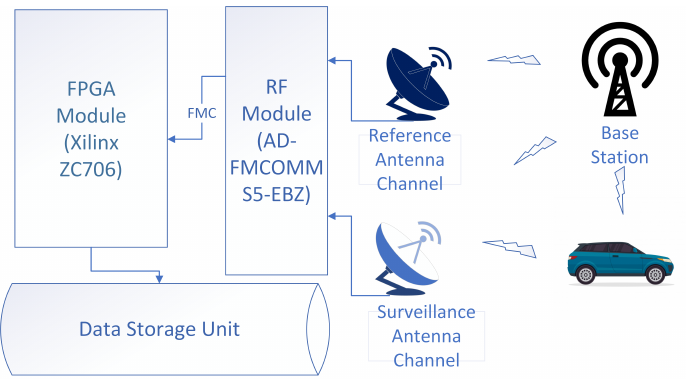
Figure 11. Architecture of the data capture